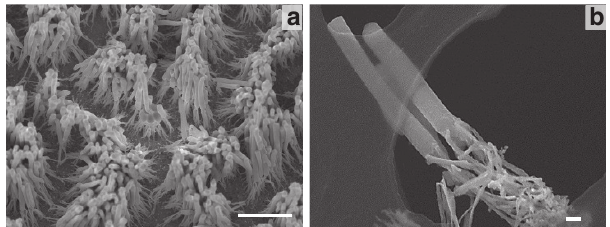
Figure 3 | Au hierarchical nanostructures. Au hierarchical nanostructures were replicated by superplastically forming a piece of Au into a hierarchical Al 2 O 3 template with multiple branched nanopores in its surface layer at B 500 (cid:2) C, under an applied force of 5kN and holding for B 10min. ( a ) SEM micrograph of fabricated Au hierarchical nanostructures. Scale bar, 1.5 m m. ( b ) Zoom-in imaging of Au hierarchical nanostructures on a TEM mesh grid (see Methods section) clearly shows the primary stems abruptly multiplied by several small branches. Scale bar,